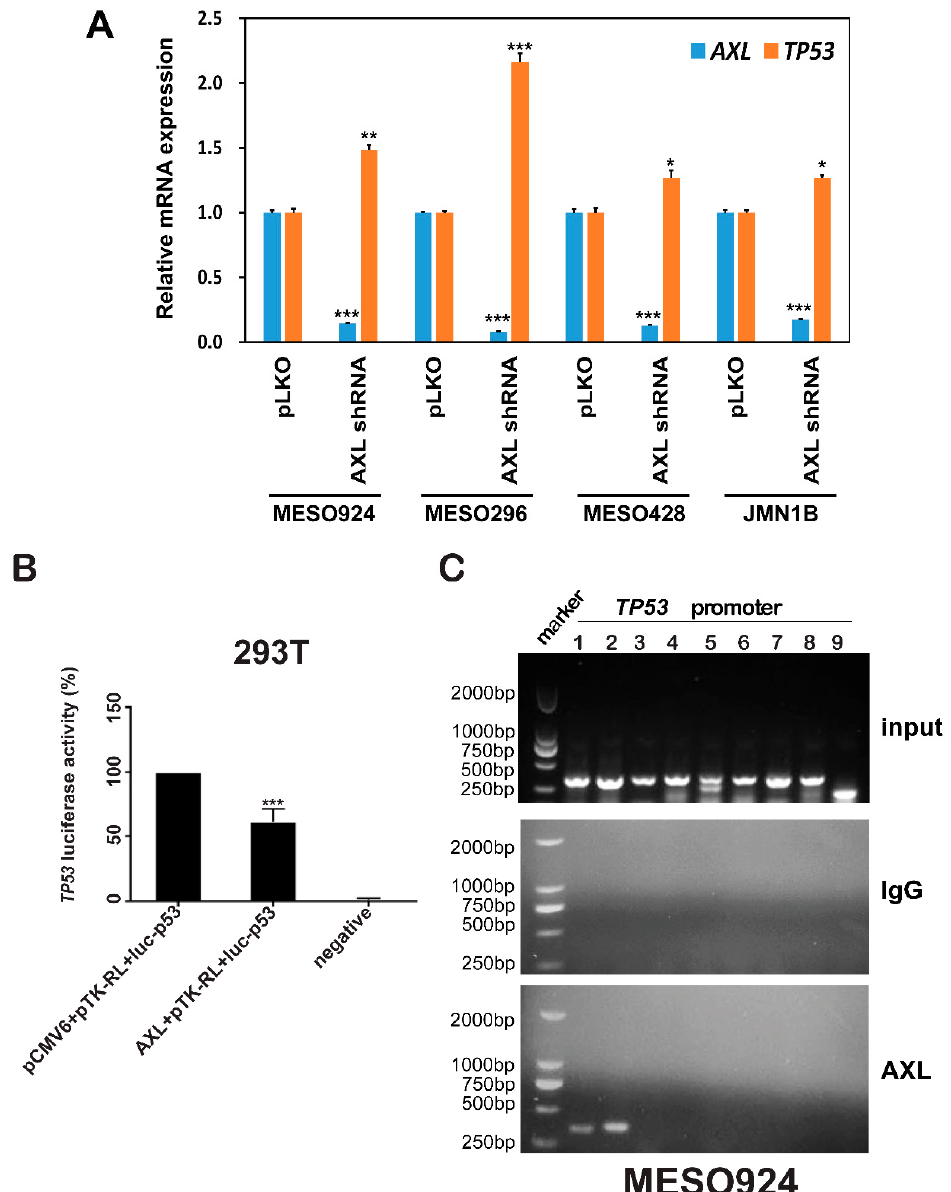
Figure 5. AXL negatively regulates TP53 transcription. ( A ) Quantitative RT-PCR evaluations of AXL (blue bars) and TP53 (green bars) transcripts at 72 h after infection of MESO924, MESO296, MESO428, and JMN1B cells with lentiviral AXL shRNA constructs. The comparative Ct (cycle threshold) method was used to determine RNA expression, which was normalized to pLKO of each cell lines in triplicate assays. Statistically significant differences are presented as * p < 0.05, ** p < 0.01, *** p < 0.001. ( B ) AXL expression inhibits TP53 promoter activity: TP53 luciferase reporter plasmid luc-p53 (0.25 µg) and Renilla luciferase reporter plasmid pTK-RL (0.005 µg) were cotransfected with pcDNA3 empty vector or AXL (0.25 µg) into 293T cells. Transfected cells were harvested at 48 h, and assessed using a Dual-Luciferase Reporter Assay System. Transfection efficiencies were normalized to the pTK-RL luciferase plasmid, and TP53 luciferase activities were normalized to the pCMV6 vector (100%). The data represent the mean values (± s.d.) from quadruplicate cultures. All the assays were performed from triplicate experiments. Statistically significant differences are presented as *** p < 0.001. ( C ) Chromatin immunoprecipitation-qPCR. TP53 promoter was amplified by nine pairs of primers and evaluated by 1% agarose gel. Chromatin immunoprecipitation showed that AXL directly binds to the first 600 bp at the 5 ′ end promoter region of TP53 . Mean ± S.D.; n = 3; IgG is a negative control.